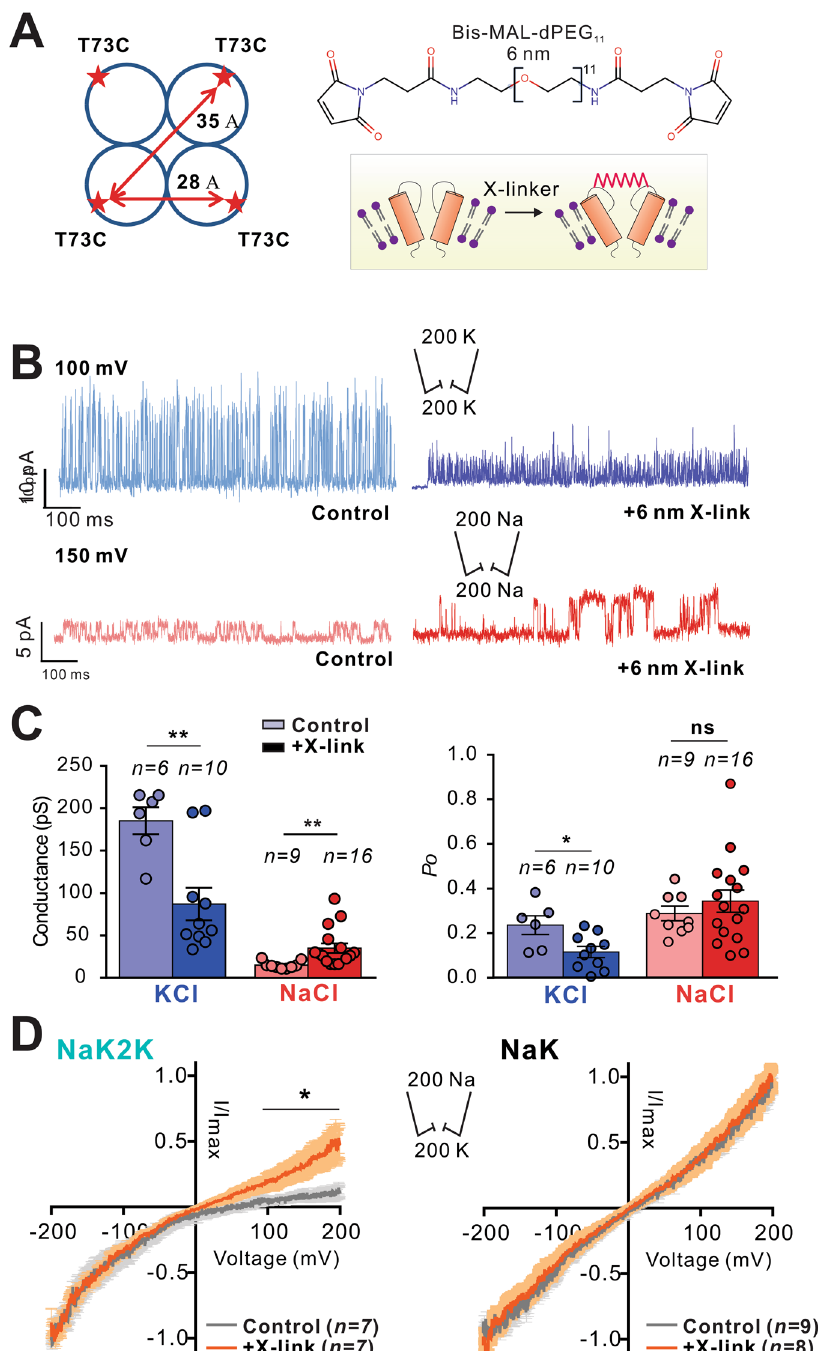
Fig.4|RestrictingextracellularSF fl exibilityreducesionselectivityofNaK2K. A Cartoon representation of the proposed crosslink location between T73C resi- dues(topofTM2)inNaK2Kusinga6nmcrosslinkertorestricttheextracellularSF fl exibility. B NaK2K T73C single-channel recordings in symmetrical 200mMK + (blue) and symmetrical 200mM Na + (red) without and with the crosslinker (light and dark color, respectively). C NaK2K single-channel K + conductance is reduced after crosslinking (blue bars), whereas Na + conductance is increased (red